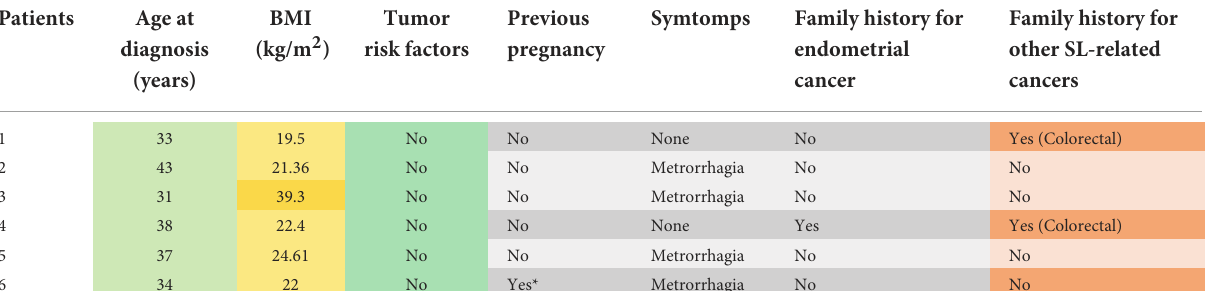
TABLE 1 Patients’ characteristics.